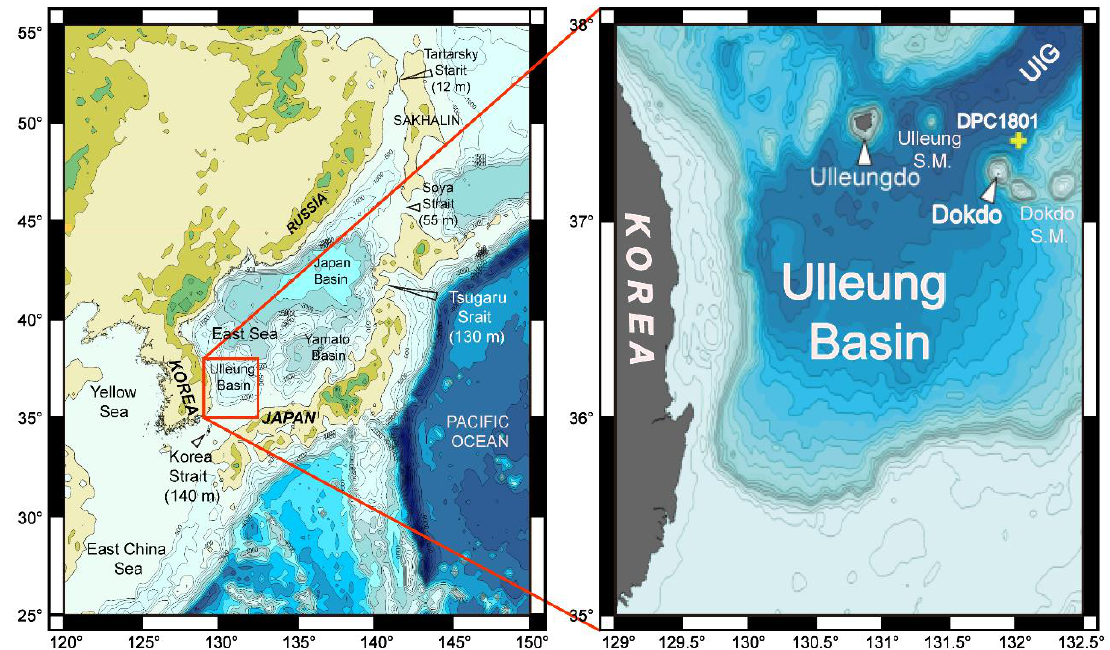
Figure 1. Map of the East Sea. In the right figure, the yellow cross is the location of the core DPC1801, and the white triangles are islands. UIG = Ulleung Interplain Gap; S.M. = seamount.